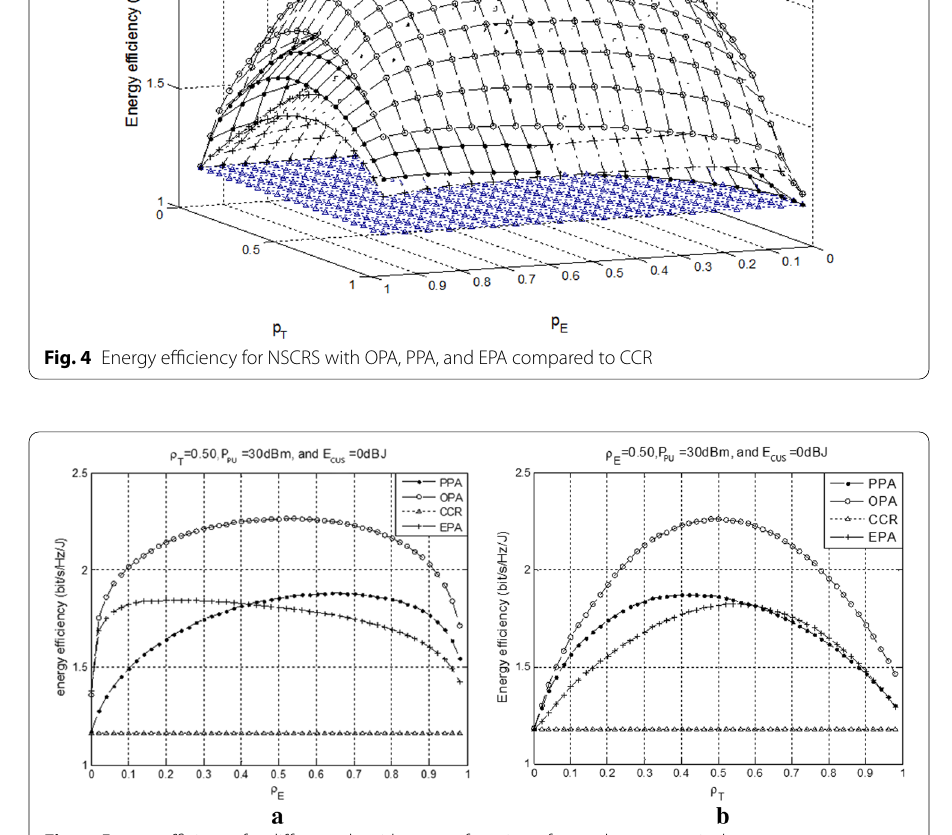
Fig. 5 Energy efficiency for different algorithms as a function of ρ E and ρ T ,